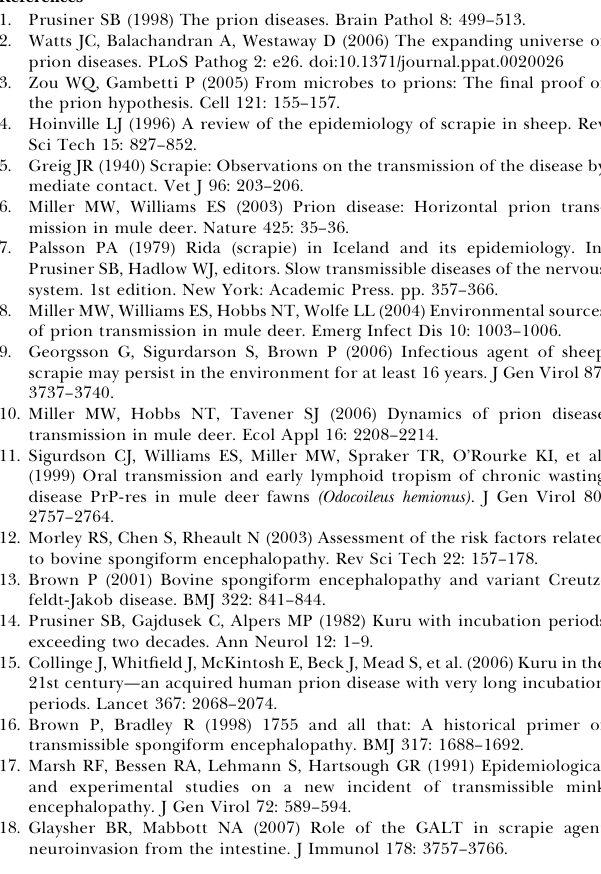
Figure S3. PK-Resistant PrP from the Brains of Clinically Infected Animals Dosed with Unbound PrP TSE and PrP TSE (cid:4) Mte